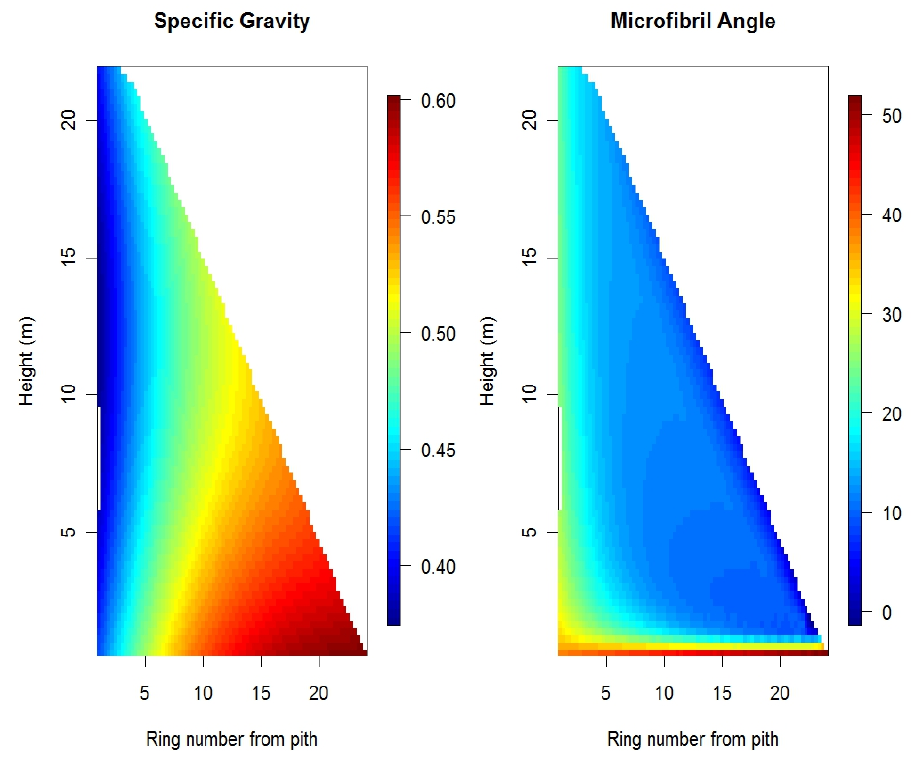
Figure 3. Maps showing within-tree variation in specific gravity (SG) and microfibril angle (MFA) for a loblolly pine tree from the Lower Coastal Plain in the United States. The SG and MFA maps were based on predictions from models proposed by He et al. [108] and Jordan et al. [112], respectively.